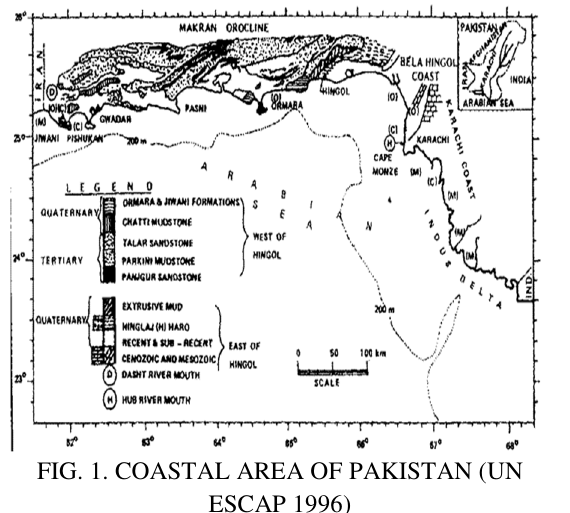
FIG. 1. COASTAL AREA OF PAKISTAN (UN ESCAP